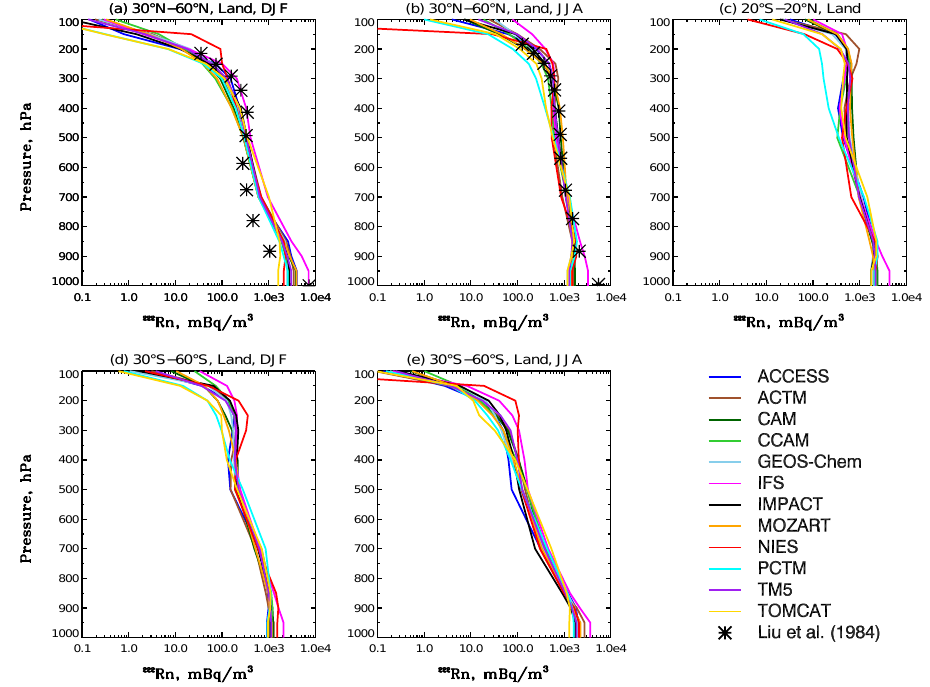
Fig. 7. Vertical profiles of radon concentration simulated by the different transport models for (a) land areas from 30–60 ◦ N during DJF, (b) land areas from 30–60 ◦ N during JJA, (c) land areas from 20 ◦ S–20 ◦ N year-round, (d) land areas from 30–60 ◦ S during DJF and (e) land areas from 30–60 ◦ S during JJA.